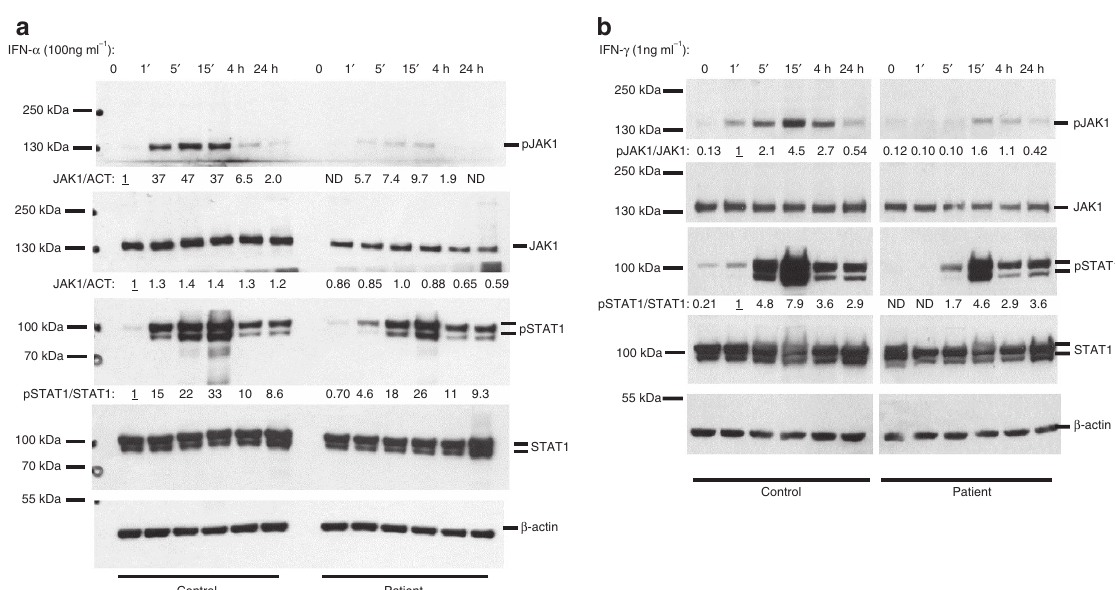
Figure 5 | Reduced JAK1 and STAT1 phosphorylation in patient’s fibroblasts at different time points after IFN- a and IFN- c stimulation. ( a , b ) Primary fibroblasts from the patient or a healthy control were treated with the IFN- a ( a ) or IFN- g ( b ) for indicated times and protein extracts were subjected to immunoblotting. Representative of two independent experiments. Fold change of band densitometry is indicated (number below bands and bar graphs in Supplementary Fig. 7).